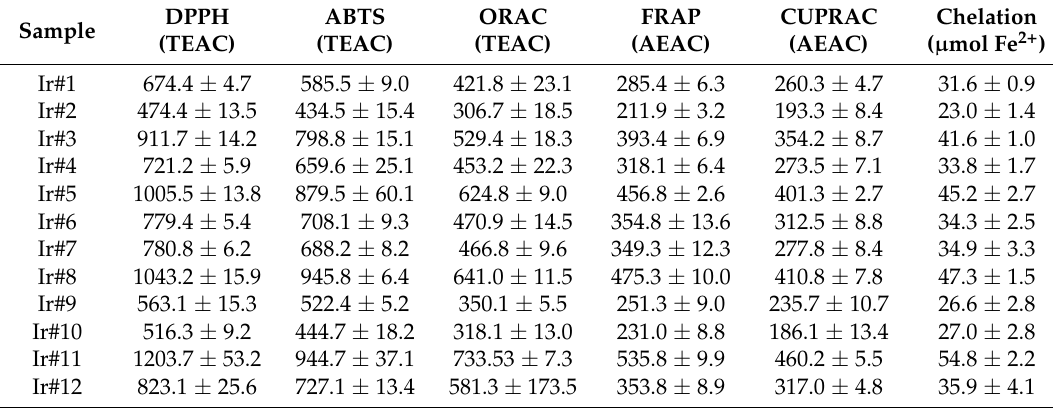
Table 3. Antioxidant activities of 12 I. rugosus callus sample extracts. (Culture conditions are presented in Table